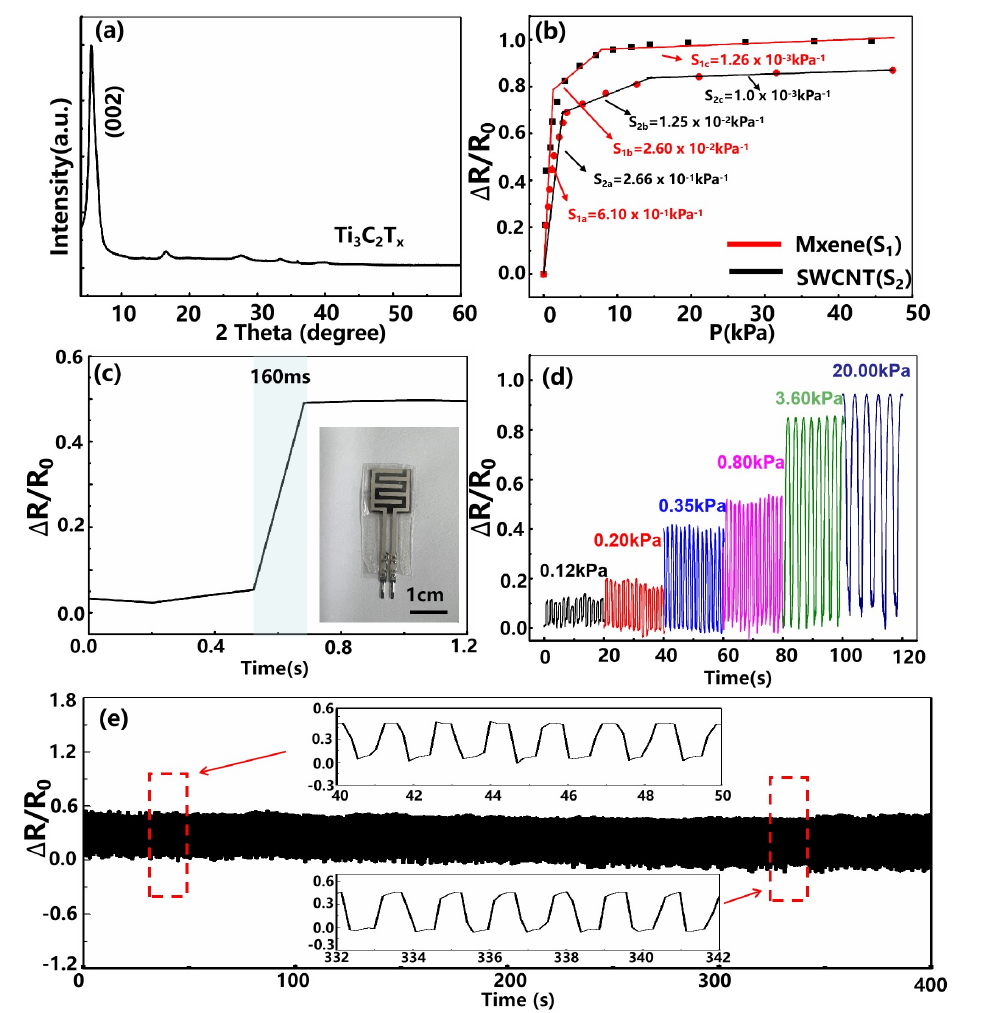
Figure 3. ( a ) XRD spectra of Ti 3 C 2 T x materials. ( b ) The resistance response versus pressure change for the filament-processed MXene-based piezoresistive sensor and the SWCNTs-based piezoresistive sensor. ( c ) Instant response of the MXene-based piezoresistive sensor. Inset: Photograph of the fabricated sensing device taken by a digital camera. ( d ) Relative resistance variation of the fabricated MXene-based piezoresistive sensor under serial pressures. ( e ) Real-time resistance response of the MXene-based piezoresistive sensor for loading/unloading cycles under 0.8 kPa, at a 0.64-Hz repetition